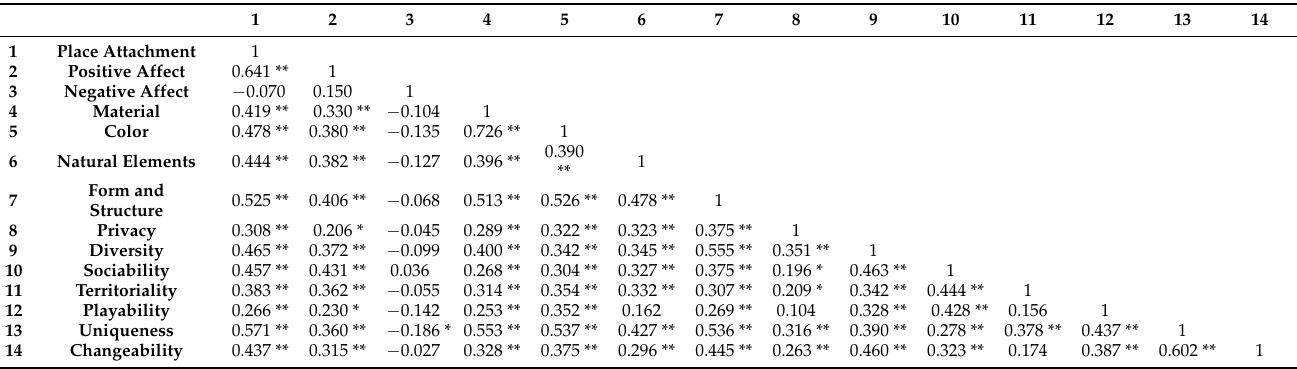
Table 3. Correlation coefficients between different attachment indicators of Beijing Fun.